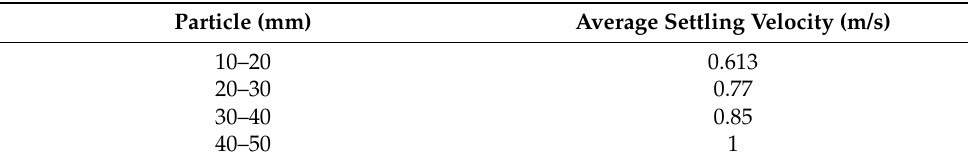
Table 3. Settling velocity of the